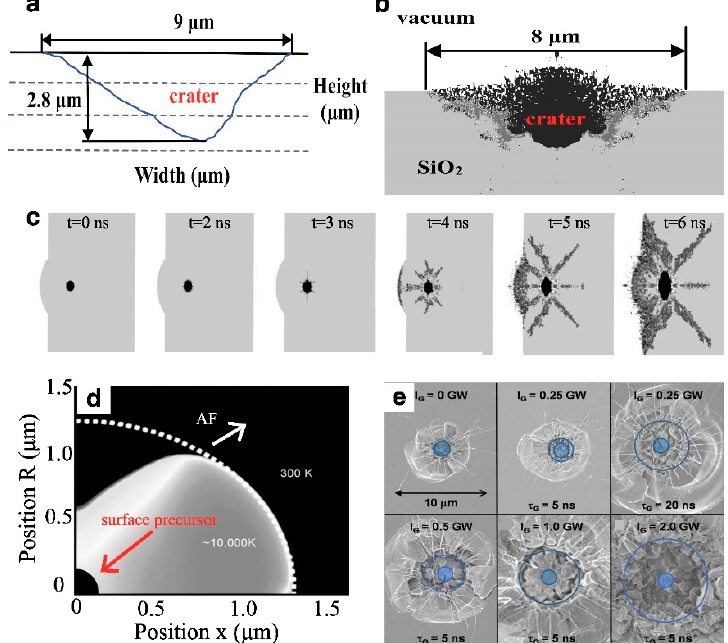
Figure 3. Contrast between the hydrodynamic simulation of laser-induced damage of optical materials containing impurities and the experimental of laser-induced damage. ( a ) Cross-sectional view of AFM (Atomic Force Microscope) measurement of damage pit by laser irradiation; ( b ) HESIONE simulation of damage pit by laser irradiation; ( c ) Illustration of the fracture wave generated by the irradiation of impurities at different times following the arrival of the laser pulse; ( d ) HD simulation of the formation of impurity absorption front (AF) while the laser was on and the temperature profile; ( e ) SEM image of the damage sites produced by absorption front initiator pulses followed by various growth feet [43,44].